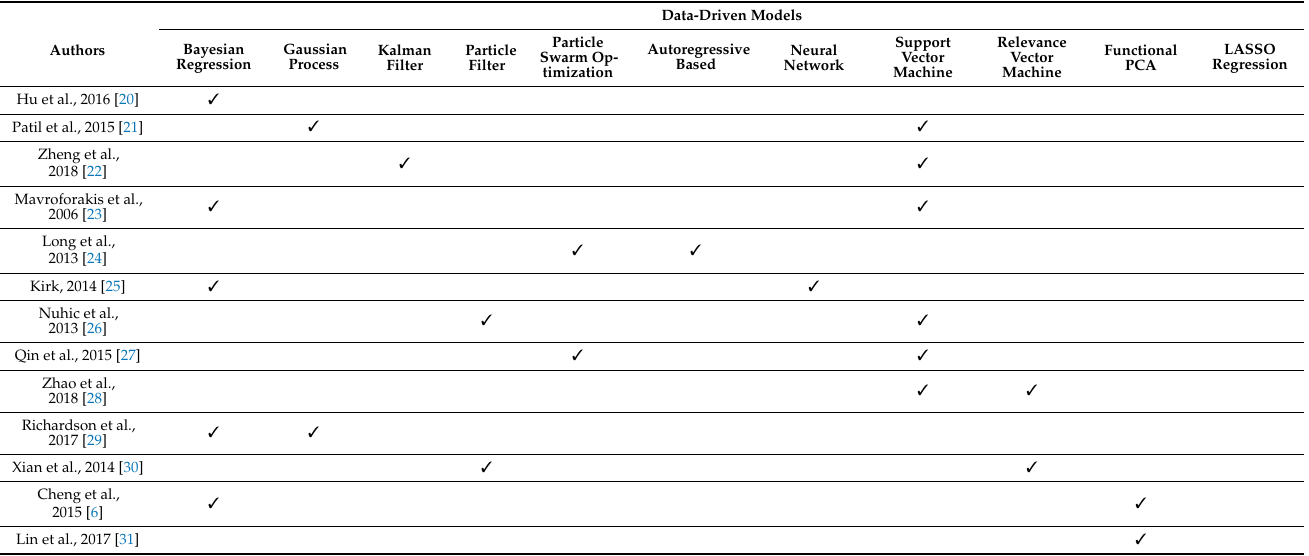
Table 1. Literature of data-driven models’ classification. The check mark indicates corresponding models used in each reference